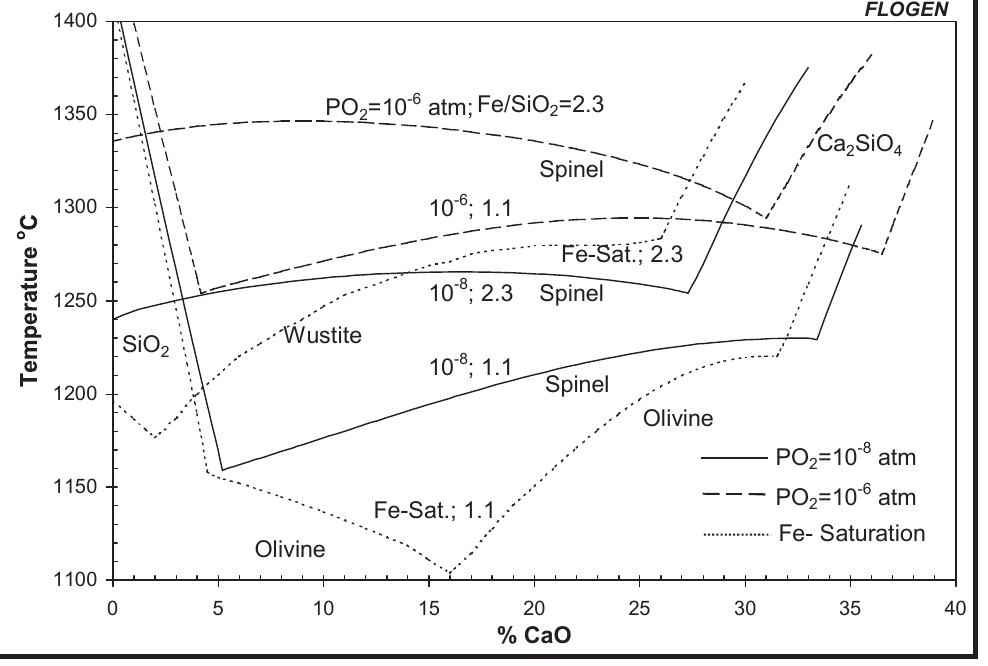
Figure 5. Effect of CaO and oxygen potential on the liquidus temperature of FeO x -SiO 2 -CaO-system at various constant Fe = SiO 2